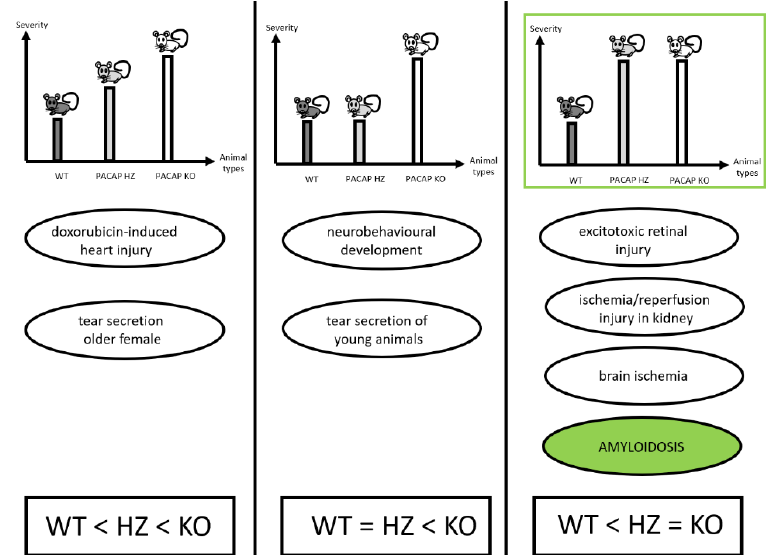
Figure 4. Summary of findings in PACAP HZ mice showing symptoms with different severity. In some reports, symptoms were between WT and KO mice in severity ( left panel), while in others HZ mice were similar to WT animals ( middle panel), and in some studies partial lack of PACAP was found to be sufficient to lead to severe symptoms, as observed in homozygous KO mice ( right panel). Based on [28,41,68–70,75].